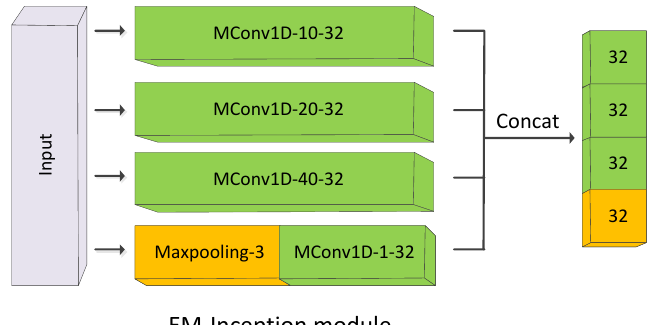
Figure 6. Architecture of the EM-Inception module, MConv1D denotes the one-dimensional MConv layer. The input of the EM-Inception module is filtered by three Mconv1D with 32 kernels which sizes are 10,20, and 40, respectively, and one max-pooling layer (stride = 3) followed by a 1 × 1 convolutional layer. The output of the EM-Inception module is a feature map with 128